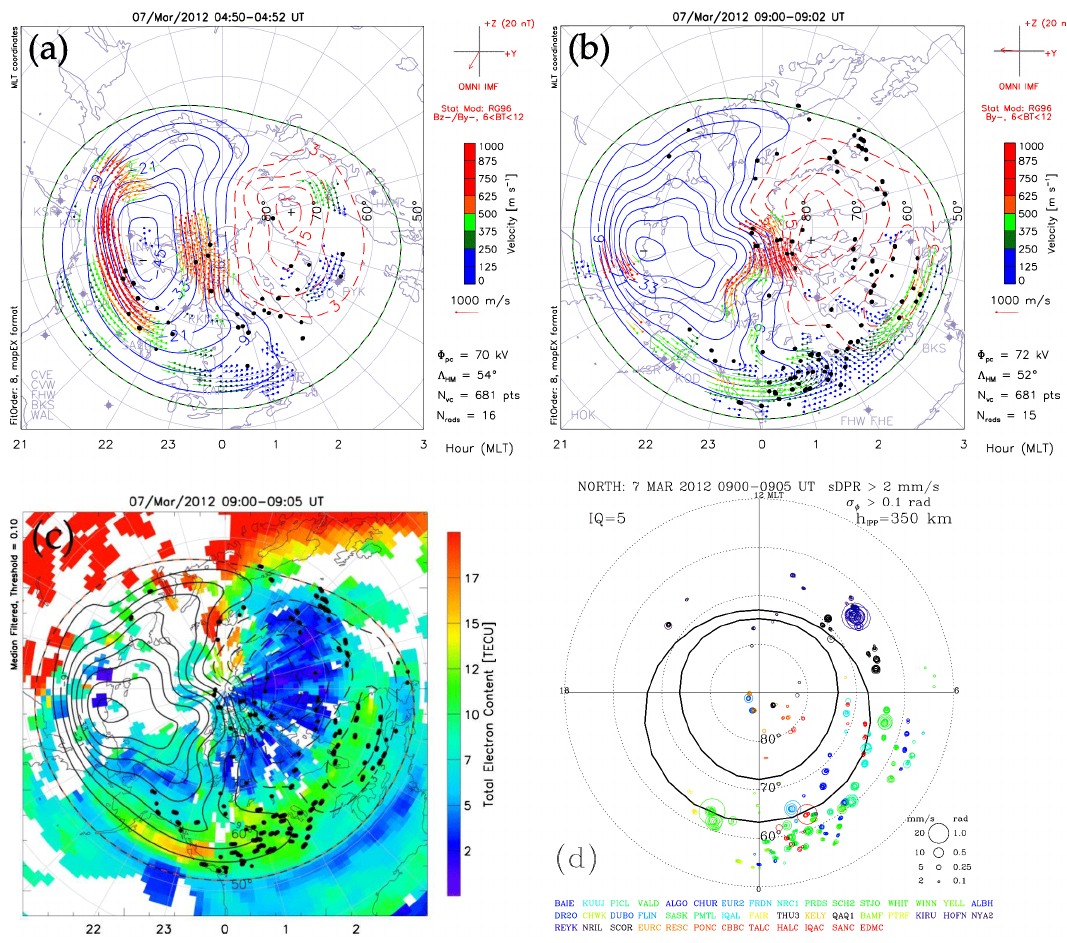
Figure 7. (a–b) Event S1: SuperDARN convection and potential maps on 7 March. The IPPs for PRNs with σ (cid:56) >0.1rad or sDPR>2mms − 1 are superposed as black dots. (c) The 5min median-filtered TEC mapped in coordinates of AACGM latitude and MLT is overlaid with the SuperDARN potential map and IPPs (black dots) for σ (cid:56) >0.1rad or sDPR>2mms − 1 on 7 March between 09:00 and 09:05UT. (d) The IPPs are shown as circles scaled proportionally to σ (cid:56) and sDPR